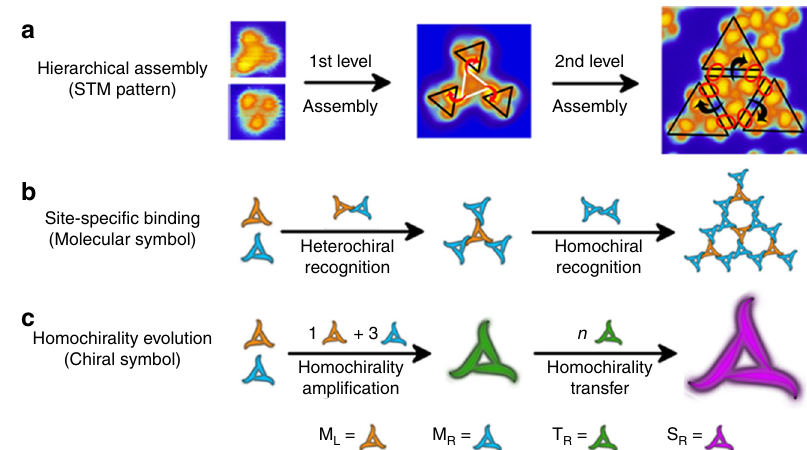
Fig. 4 Homochirality evolution in the hierarchical assembly. a Directional site-speci fi c binding in the hierarchical assembly. The STM image sizes of valinomycin monomer, tetramer, and supramolecular network portion are 3 nm × 3 nm, 6 nm × 6 nm, and 12 nm × 12 nm, respectively. The directional binding sites were highlighted with circles and arrows. b Schematic diagram of the recognition way of subunits in the hierarchical assembly. c Schematic drawing of the homochirality evolution in the hierarchical